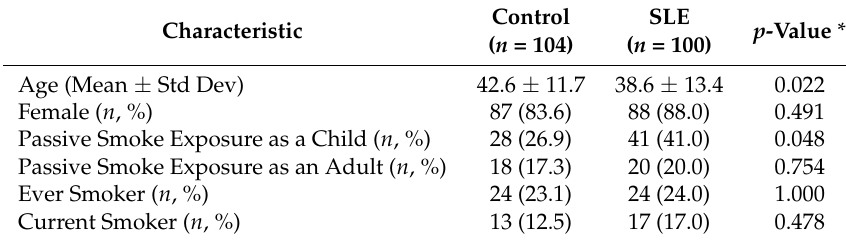
Table 1. Participant characteristics by SLE